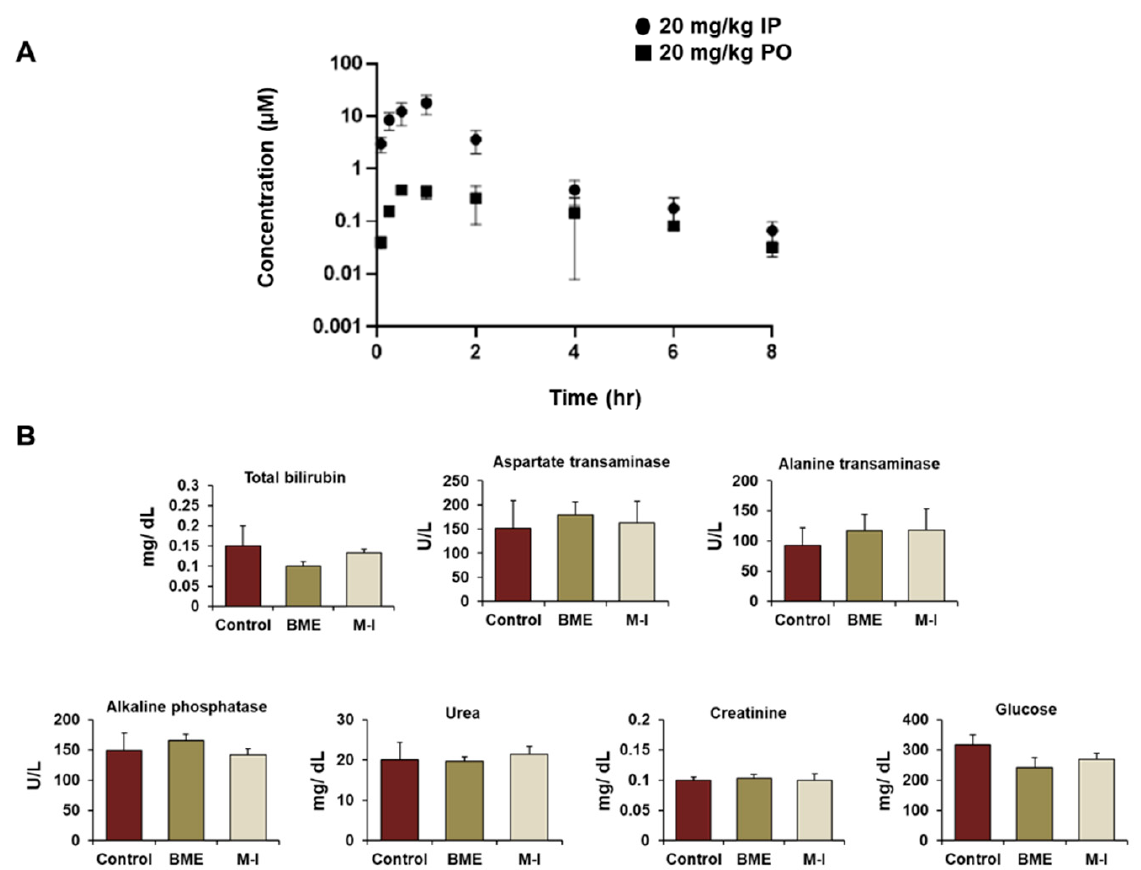
Figure 5. In vivo pharmacokinetic and toxicity profile of momordicine-I. ( A ) Concentration-time profile of momordicine-I in C57Bl/6 male mice at 20 mg/kg single dose administered by IP injection or oral gavage (PO). Data is from n = 3 mice and represents mean ± standard deviation. ( B ) Comparison of metabolic panel from serum among M-I (30 mg/kg/mouse) and BME treated groups with untreated control mice. Small bar indicates standard